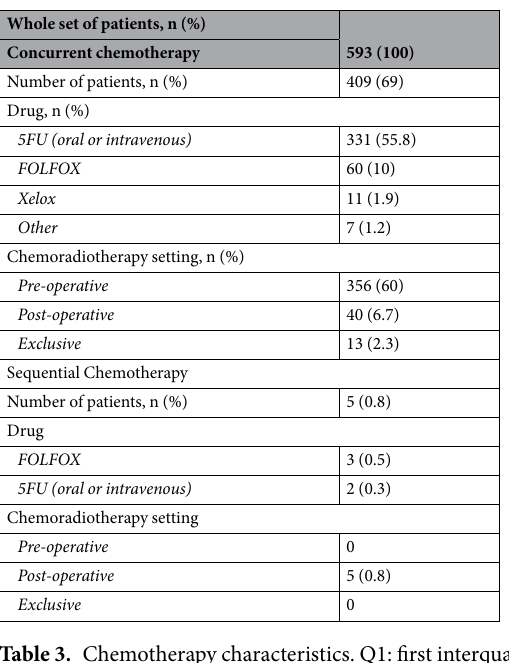
Table 3. Chemotherapy characteristics. Q1: first interquartile, Q3: third interquartile.